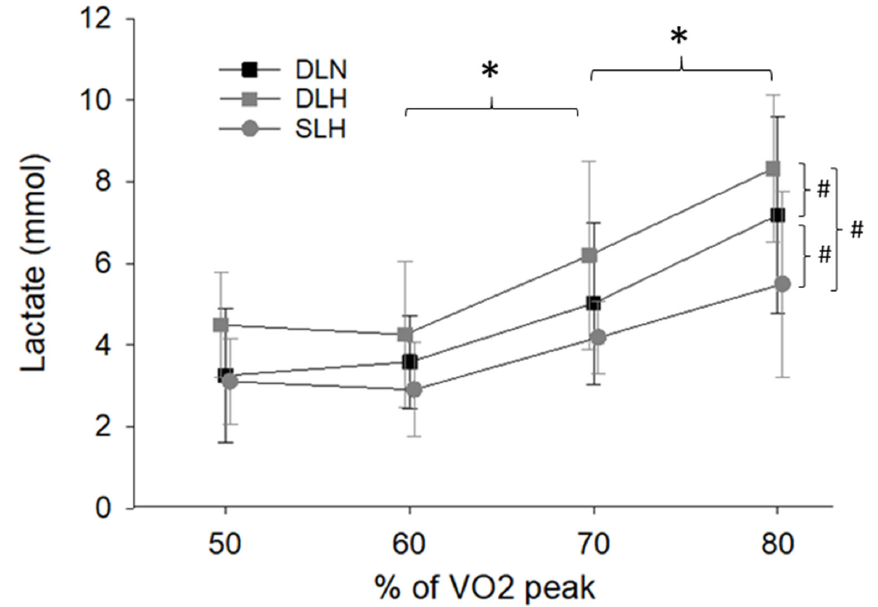
Figure 6. Blood lactate concentrations across the 4 submaximal cycling intensities and 3 cycling conditions lactate. * Indicates significant main effect of cycling intensity whereas # indicates a significant main effect of condition. Lactate increased from 60% to 70% VO 2 peak and increased again from 70 to 80% VO 2 peak. Lactate was also greater during double-leg cycling in hypoxia compared to double-leg cycling in normoxia. Lactate was lowest during the single-leg hypoxic condition. DLN = Double-Leg Normoxia; DLH = Double-Leg Hypoxia; SLH = Sigle-Leg